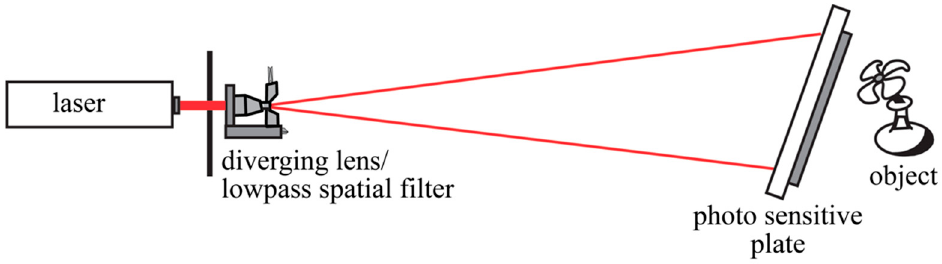
Figure 2. Creating a reflection volume hologram: laser illumination is brought to a photo-sensitive plate from the opposite side as the object; when the resulting hologram is illuminated with white light from the same side as the original laser, a 3D image of the object is reconstructed.